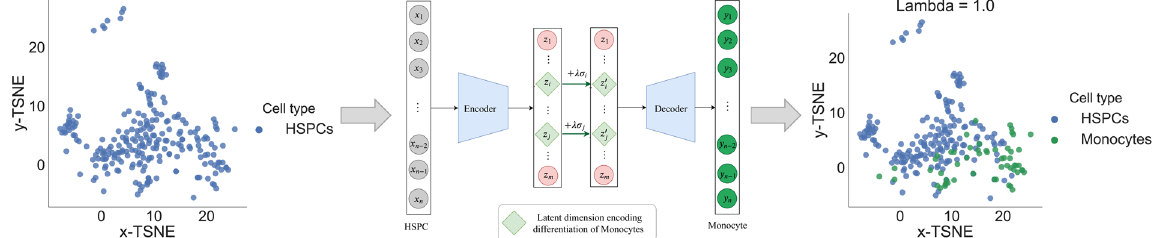
Figure 2. Methodology proposed for changing the cellular states: HSPCs can be converted into Monocytes by shifting the latent dimensions differentiating Monocytes by a factor λ multiplied with their standard deviation. Increasing the shifting parameter λ will result in more of the HSPCs to be subsequently classified as